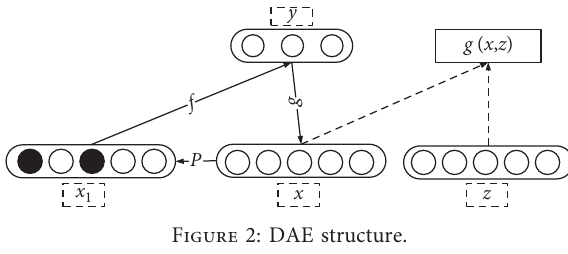
Figure 2: DAE structure.